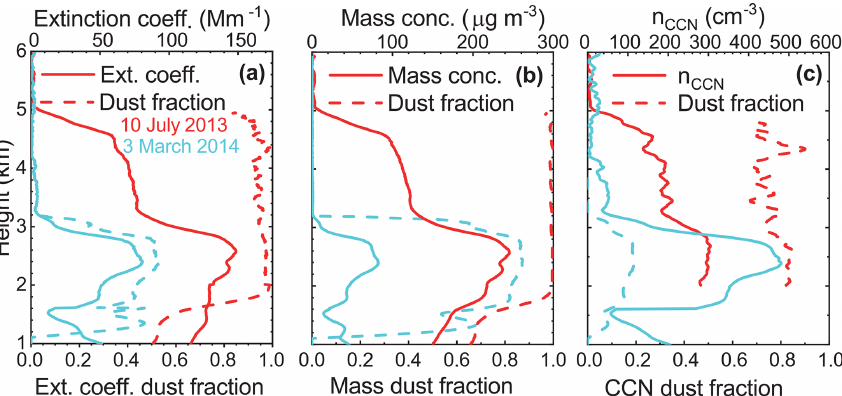
Figure 8. Summer (10 July 2013; red) versus winter (3 March 2014; cyan) aerosol conditions in the SAL. (a) Total particle extinction coefficient (solid line) and relative dust contribution to the total particle extinction coefficient (dashed line). (b) Same as (a) except for dust mass concentration. (c) Same as (a) except for CCN